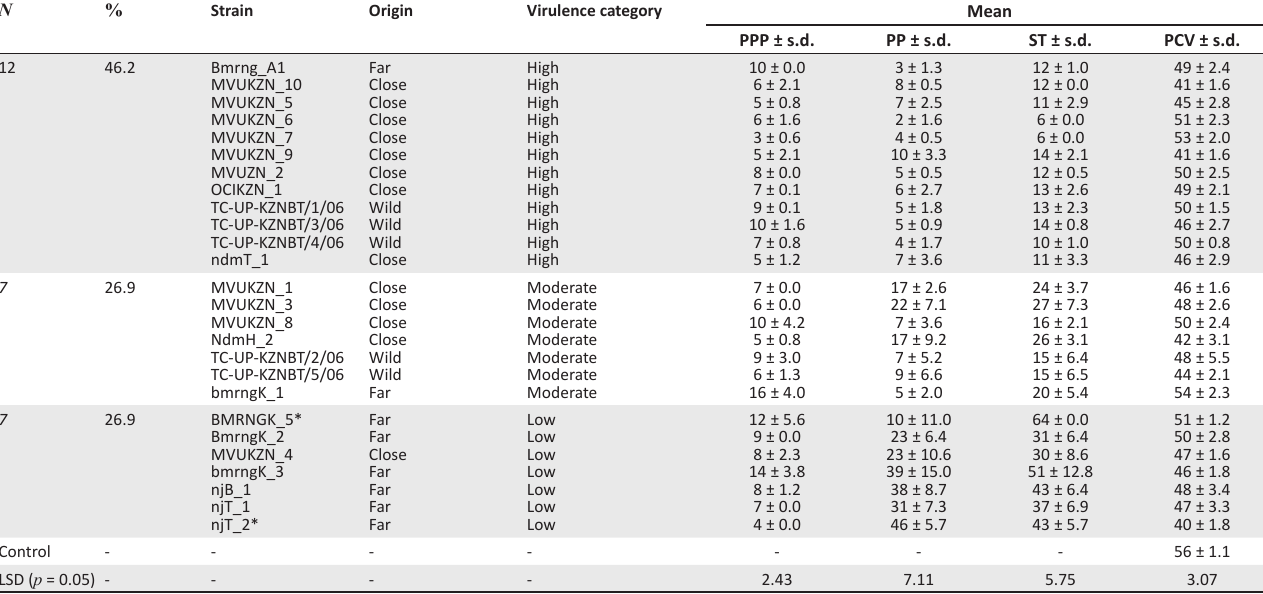
TABLE 1: Means with standard deviations to compare and group strains into high, moderate and low virulence categories using the least significant difference. N %